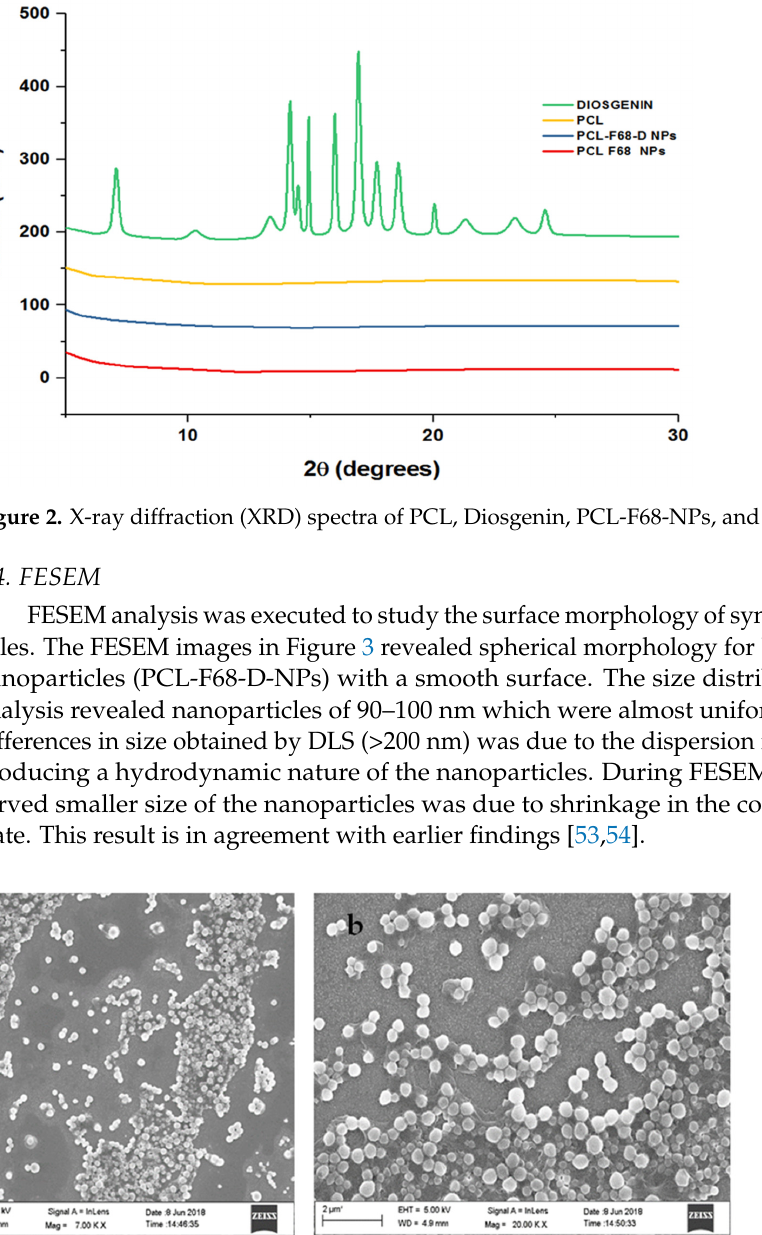
Figure 3. Field emission scanning electron microscope (FESEM) images ( a , b ) of Diosgenin-loaded nanoparticles